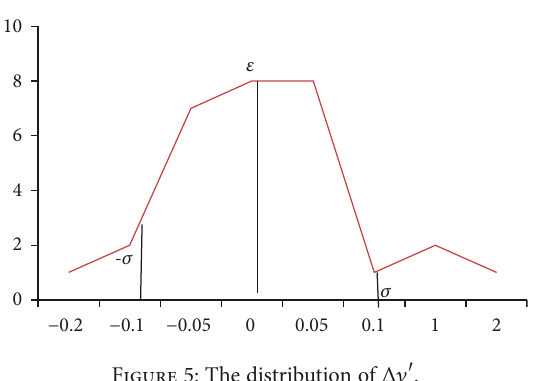
Figure 5: The distribution of Δ γ ′